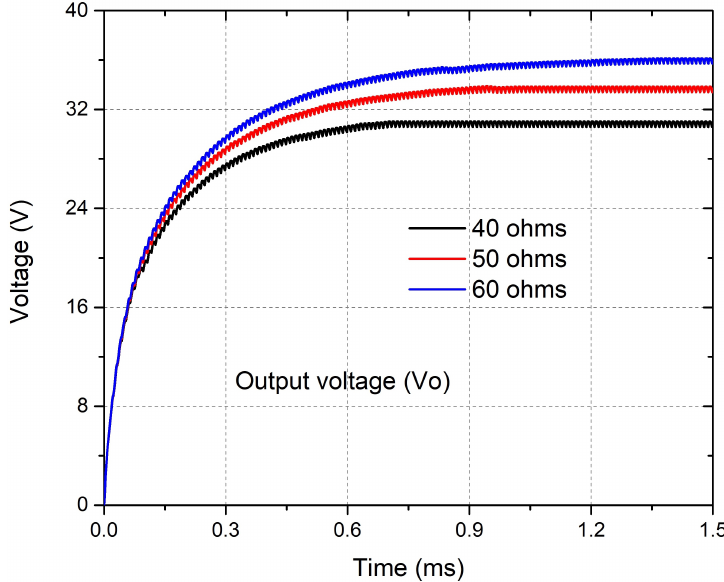
Figure 19. Output voltage plot obtained using the proposed algorithm. The output power obtained using the proposed algorithm is shown in Figure 20. The average output power obtained for a load of 40 Ω is 22.79 W, 21.65 W for 50 Ω and 20.57 W for 60 Ω . The duty cycle obtained for these different values of the load is shown in Figure 21, the final duty cycle is 79% for a load of 40 Ω , 83% for a load of 50 Ω and 84% for a load of 60 Ω . With the values obtained from the simulation, it can be determined that the power obtained using the proposed algorithm is 4% larger than using P&O algorithm when the load is 40 Ω , 5.5% larger for a load of 50 Ω and 6% larger for a load of 60 Ω .